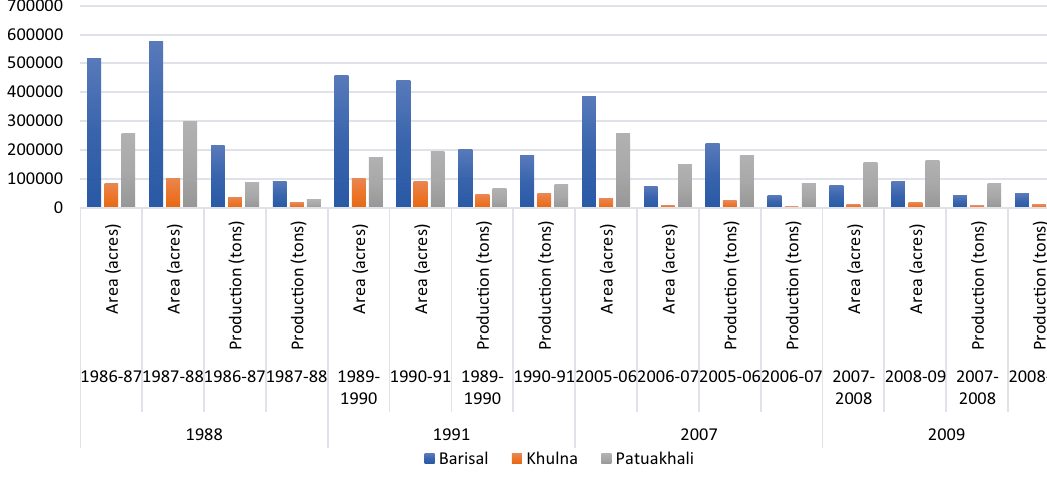
Fig. 5 Production and area variance of Aus Rice. Source: “45 years Agriculture Statistics of Major